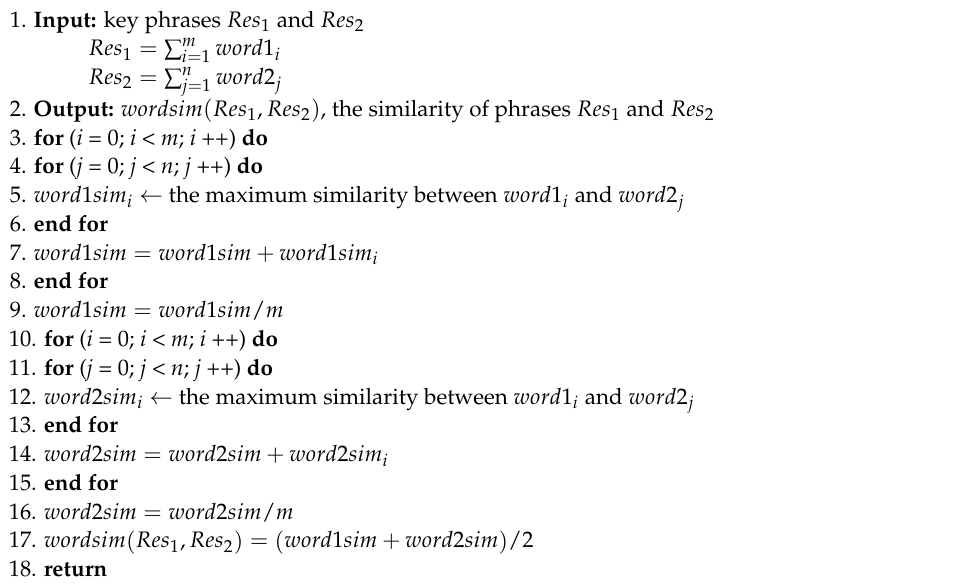
Algorithm 2. The Algorithm of Phrase Similarity Calculation